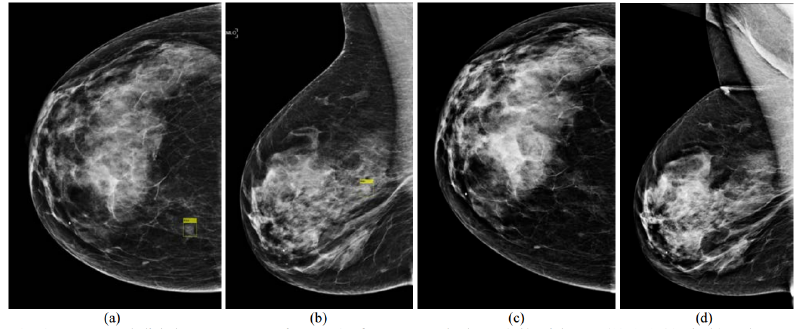
Figure 4. Digital mammogram pairs. ( a , b ) Right CC (1051 × 1521 pixels) and MLO (1069 × 1746 pixels) views of the recent mammogram with a mass present and marked by a yellow rectangle. ( c , d ) Right CC and MLO from a prior exam 1 year earlier (not aligned yet), which was normal (reprint with permission from